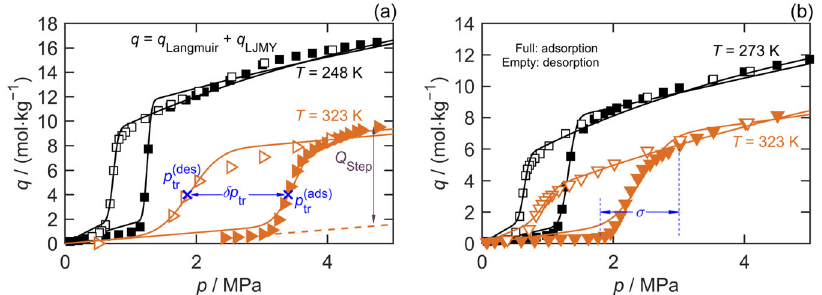
Fig. 1 Exemplar hysteretic sorption isotherms for CH 4 on the MOFs measured by Mason et al. 2 , illustrating the key parameters in Equation 1. a Fe(bdp) and b Co(bdp). Full symbols denote the adsorption branch and hollow symbols denote the desorption branch. Squares denote the lower temperature isotherm and triangles the higher